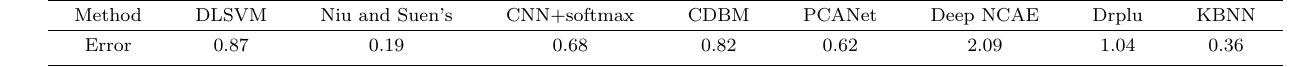
Table 2 Classification errors (%) on MNIST